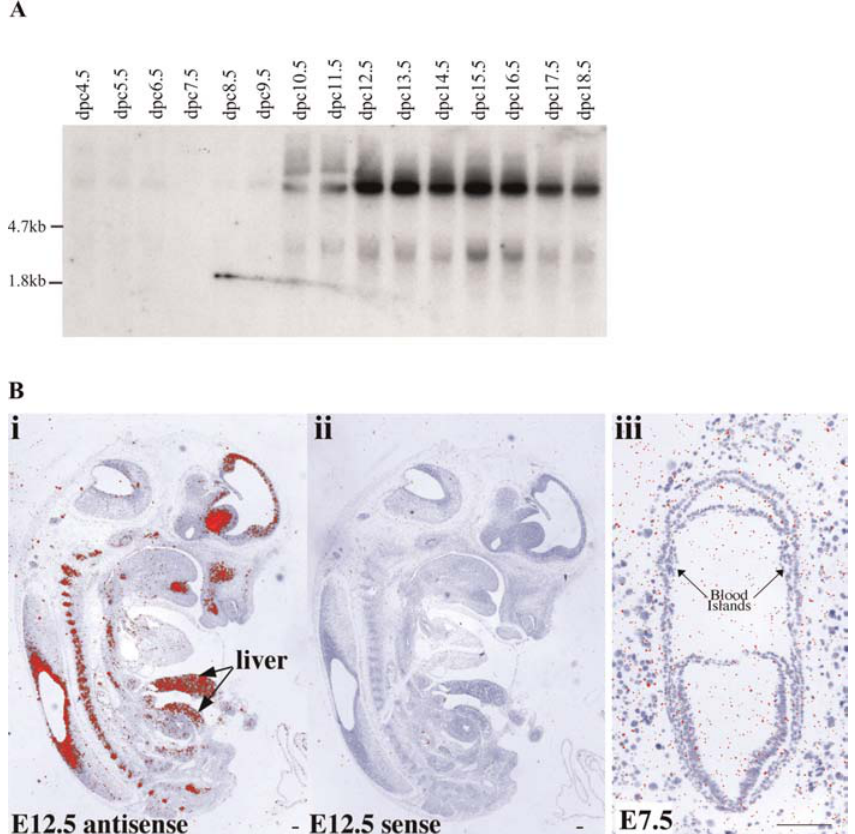
Figure 6. Expression Pattern of Sox6 by Northern Blot and In Situ Assays (A) Sox6 expression during embryonic development shown by Northern blot. Each lane contains 20 l g of total RNA from embryos whose ages are listed above each lane as dpc. The filter was hybridized with a 32 P-labeled 575-bp mouse Sox6 cDNA fragment (nucleotides 1353–1927). Numbers on the left are sizes of standard marker fragments in kb. (B) Sox6 expression shown by in situ hybridization. Panel i: Sagittal section through an E12.5 mouse embryo using antisense Sox6. mRNA distribution